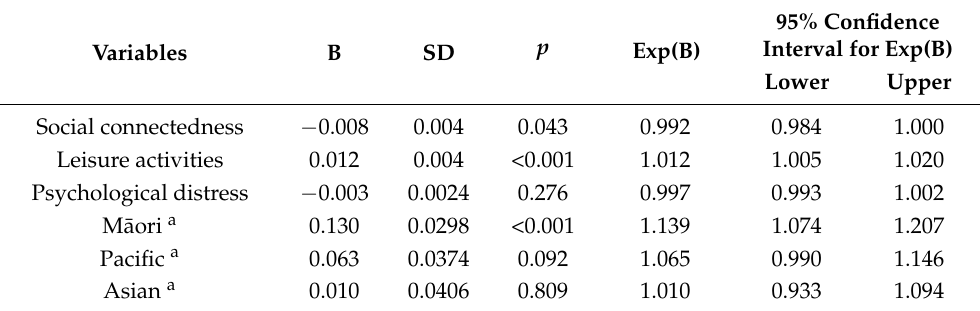
Table 4. Poisson regression results—gambling activity count, social connectedness, leisure activities, psychological distress, and